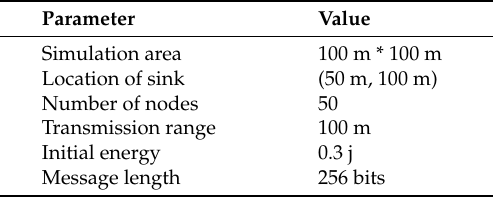
Table 1. Simulation